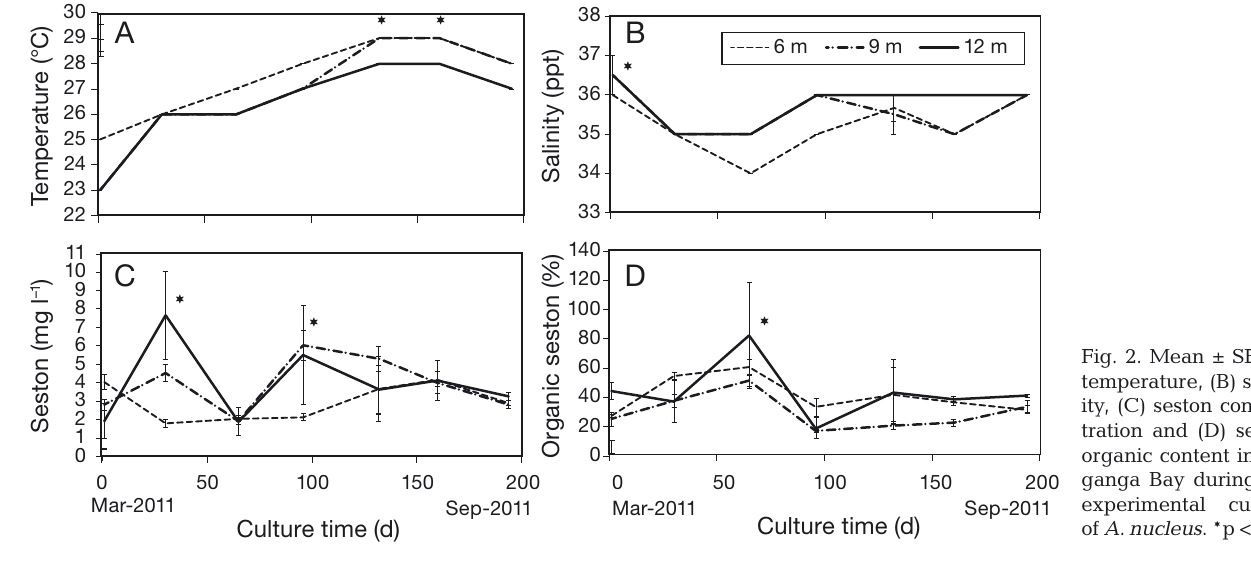
Fig. 2. Mean ± SE (A) temperature, (B) salin- ity, (C) seston concen- tration and (D) seston organic content in Ta - gan ga Bay during the experi mental culture of A. nucleus . *p <